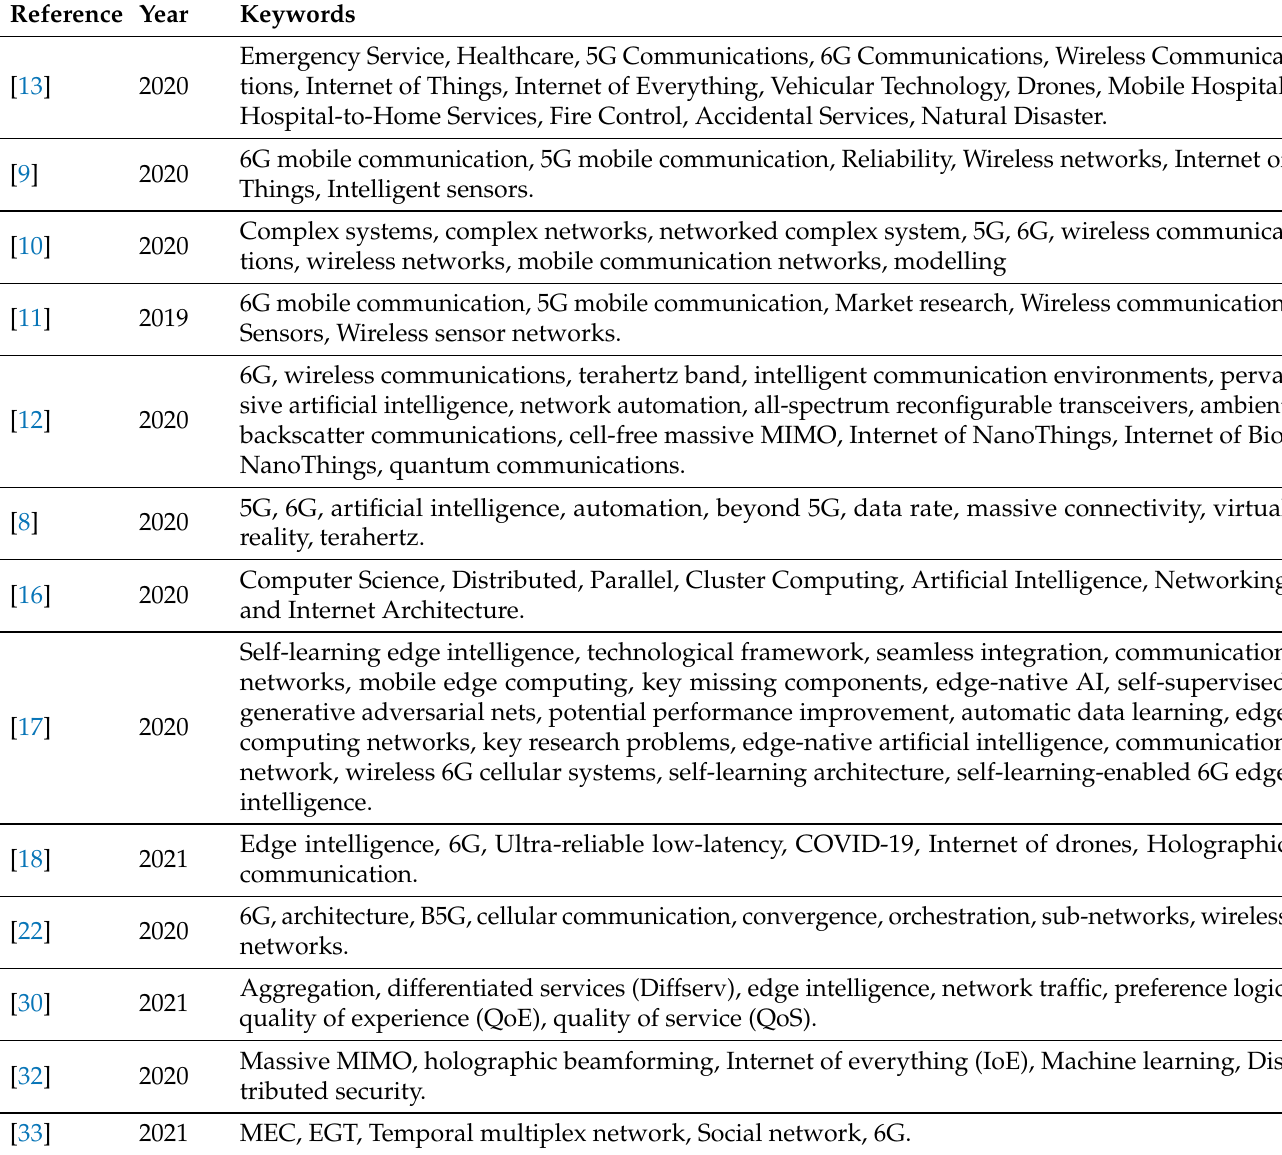
Table 2. Research works about 6G